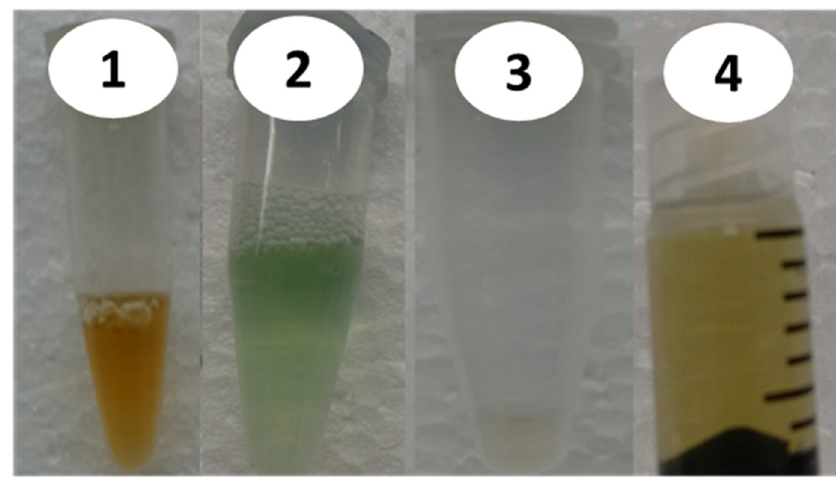
Figure 6. Pt NHase in 50 mM HEPES pH 7.0 buffer at room temperature; (1) 0.54 mM Pt NHase WT, (2) 0.16 mM Pt NHase α Cys108Ser, (3) 0.50 mM Pt NHase α Cys108His, (4) 0.43 mM Pt NHase α